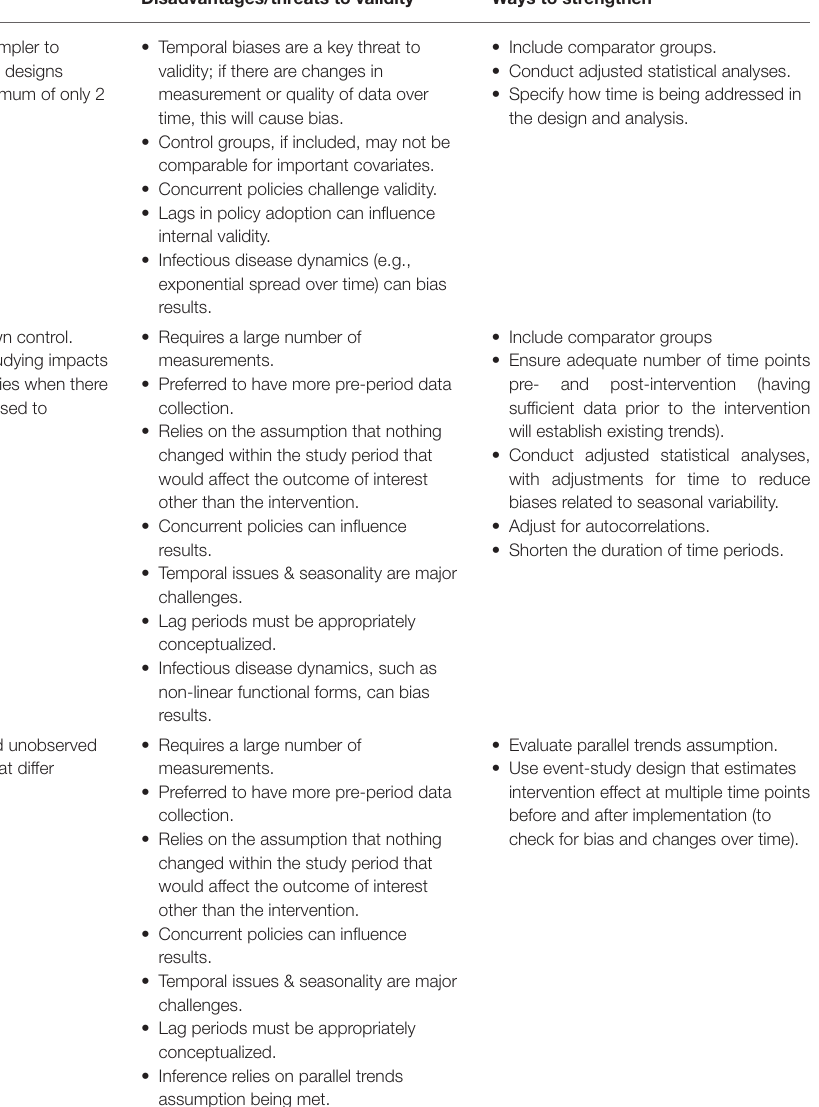
TABLE 1 | Overview of quasi-experimental designs.